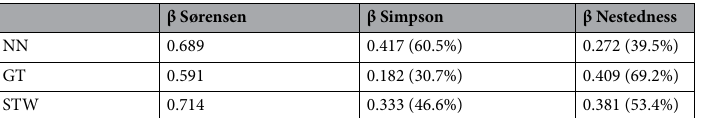
Table 1. β Sørensen dissimilarity index between the new assemblages and the Paris Biota defined at Paris Canyon, together with the β Simpson (accounting for species turnover) and the β Nestedness dissimilarity components. Numbers in brackets represent the percentage of explained total dissimilarity.